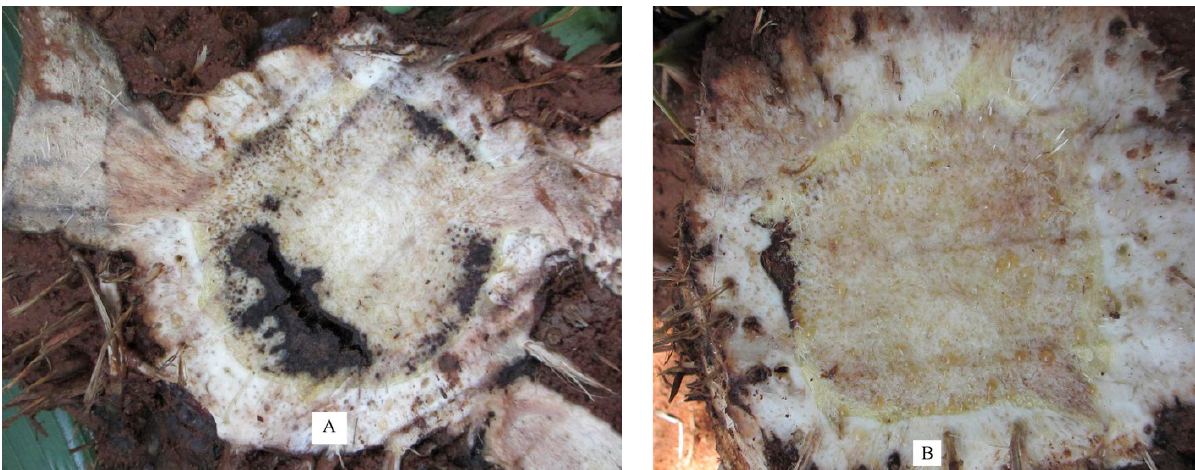
Figure 1. The internal symptom of vascular discolouration in corm tissues of field-grown banana plants of cv. Grand Naine, in untreated control plants (A) and bacterial isolates-treated plants (B). The plant in B was treated with e ndophytic Bacillus flexus (TvPr1) + rhizospheric Bacillus cereus (Jrb1). Table 4. Field evaluation of combined applications of endophytic (endo.) and rhizospheric (rhizo.) bacterial isolates for the suppression of Fusarium wilt in banana cv. Grand Naine Endo. Pseudomonas putida (C4r4) + rhizo. Bacillus cereus (Jrb1)